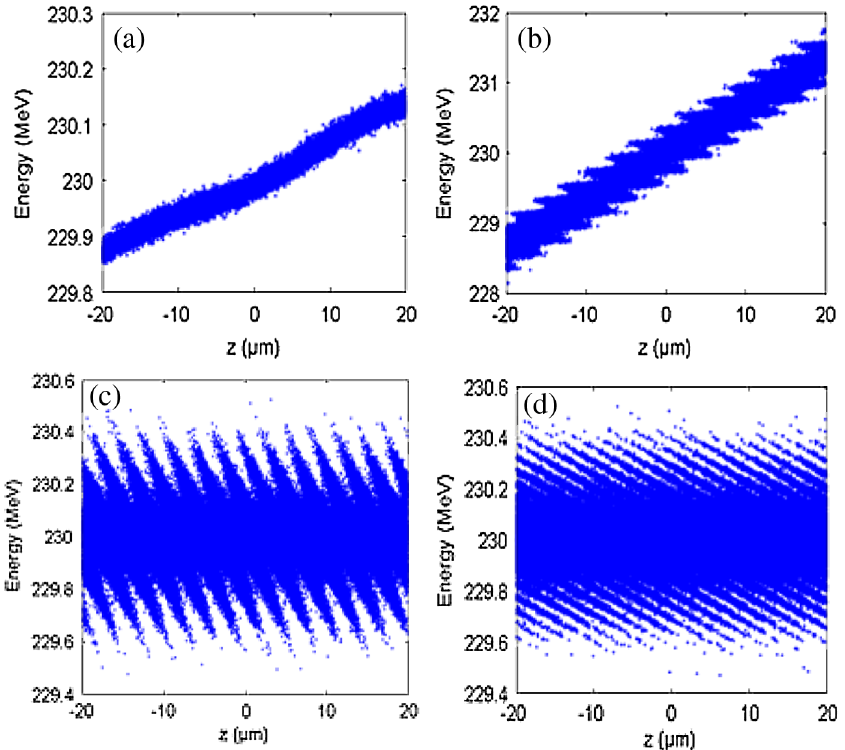
FIG. 5. (Color) 1D linear tracking of the longitudinal phase space. (a) An energy modulation was superimposed to the linear energy chirp entering BC1; 10 keV rms uncorrelated energy spread is present. (b) As a result of the bunch length compression (by a factor of 10) in BC1, the longitudinal phase space apparently rotates. (c) The longitudinal phase space is flattened by removing the linear energy chirp. (d) A further ‘‘rotation’’ allows the particles to longitudinally